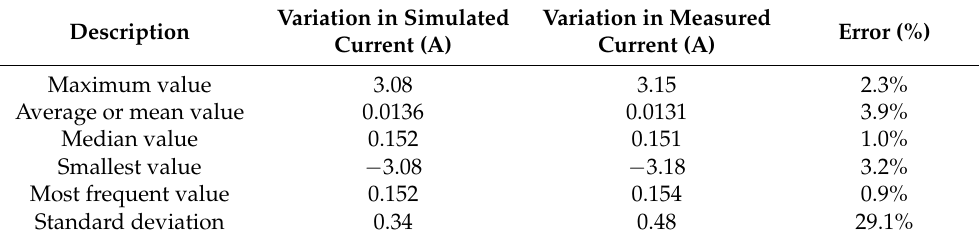
Table 9. Comparison between simulated and measured current—data statistics for motor M2.